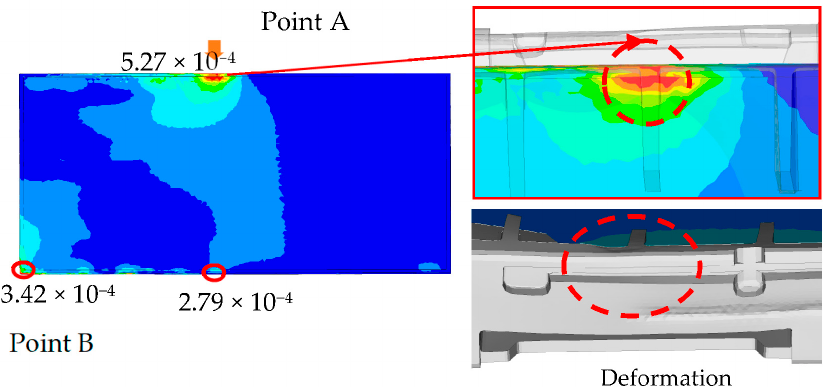
Figure 8. Impact of EPS cushion design on product performance.